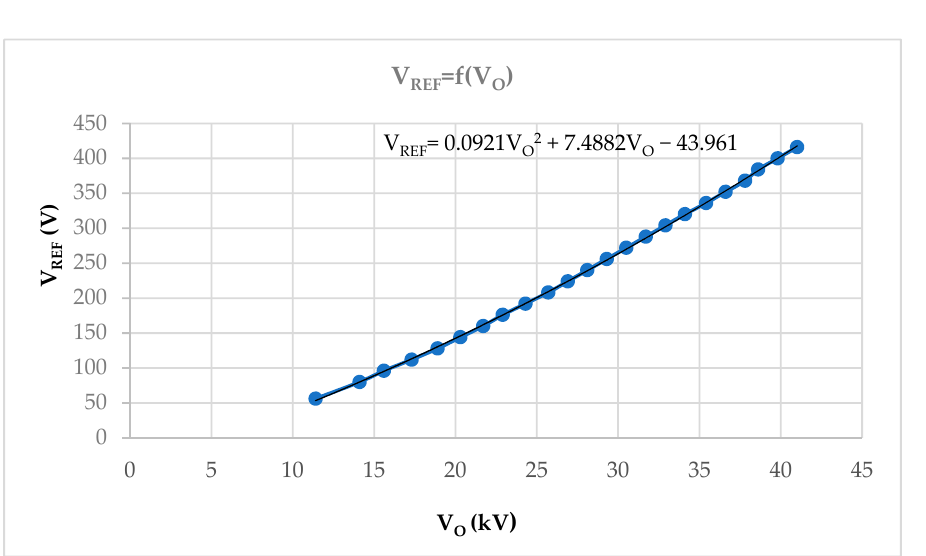
Figure 9. Experimentally determined function correcting the relation between input voltage and gain of the resonant DC-DC converter.